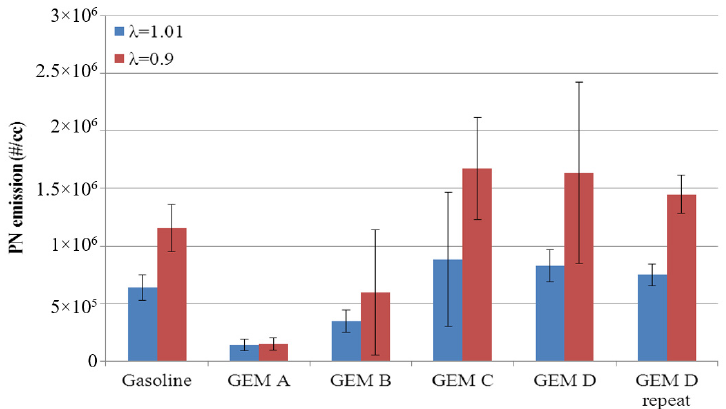
Figure 21. PN emissions from GEM fuels at 2.6 bar IMEP. Error bars correspond to ± σ .